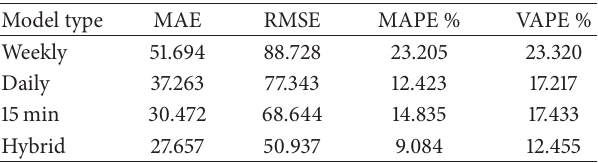
Table 3: Comparison of prediction performance of weekly, daily, 15min, and hybrid